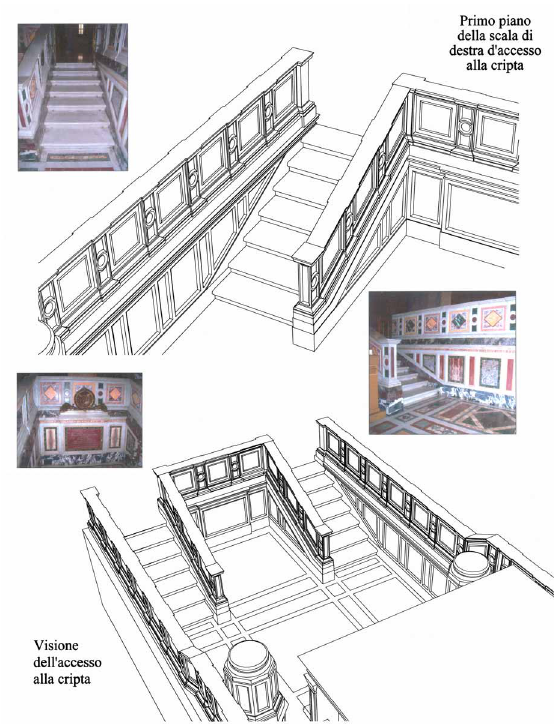
Figure 16. Axonometric view of the access ramp to the crypt (the Basilica of San Pietro in Vincoli in Rome).